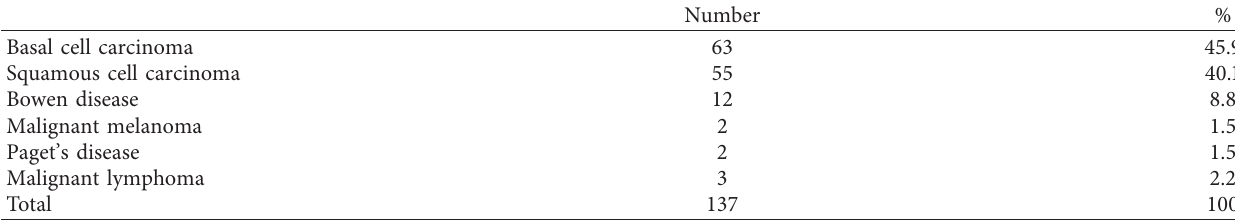
Table 1: Frequency of the main skin